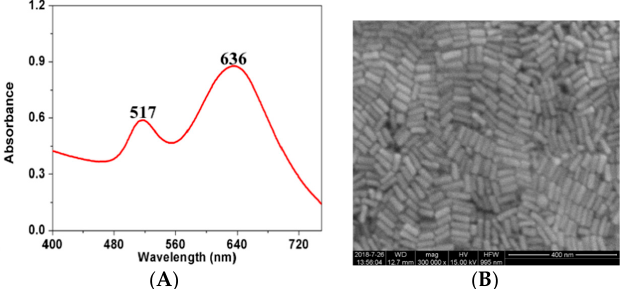
Figure 1. UV–Vis spectrum of the prepared gold nanorods’ (GNRs) colloid (A) and SEM image of GNRs (B).